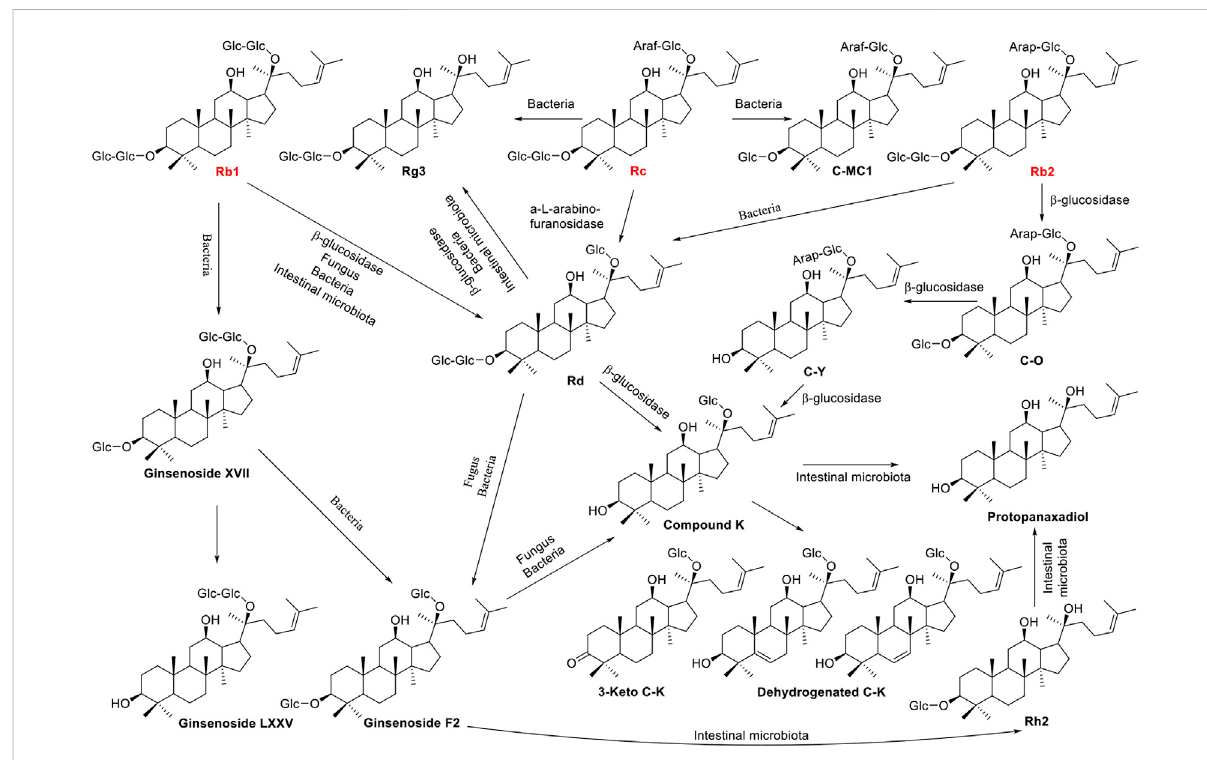
FIGURE 3 Schematic illustration of biotransformation of major PPD-type ginsenosides Rb1, Rb2, and Rc into minor